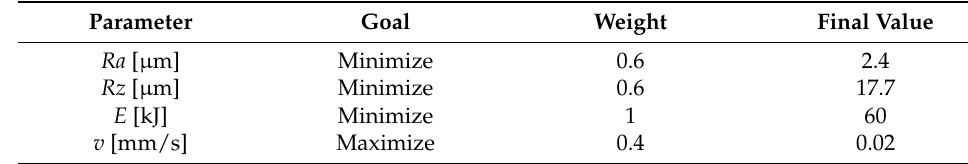
Figure 11. Diagram for selecting the optimum I and v s process parameters. Table 7. Criteria, parameters, and optimization results.